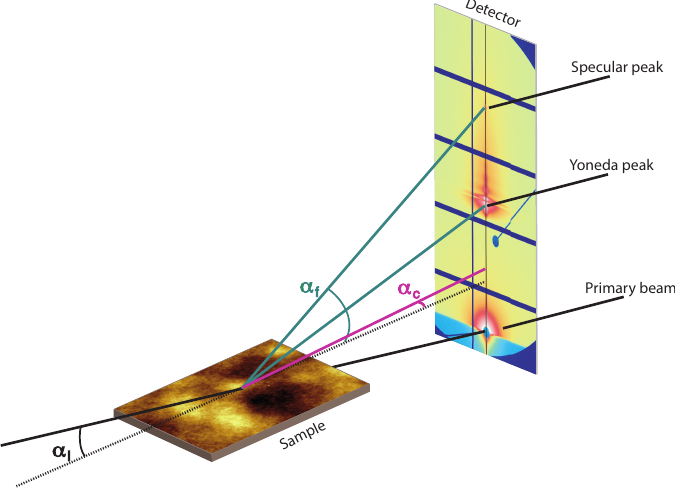
Figure 2. Schematic illustration of a GISAXS setup with X-rays hitting the sample under a grazing incident angle α i . The direct beam transmits the sample (primary beam on the 2D-detector), X-rays are reflected (specular peak) and scattered. At α i + α c the so called Yoneda peak